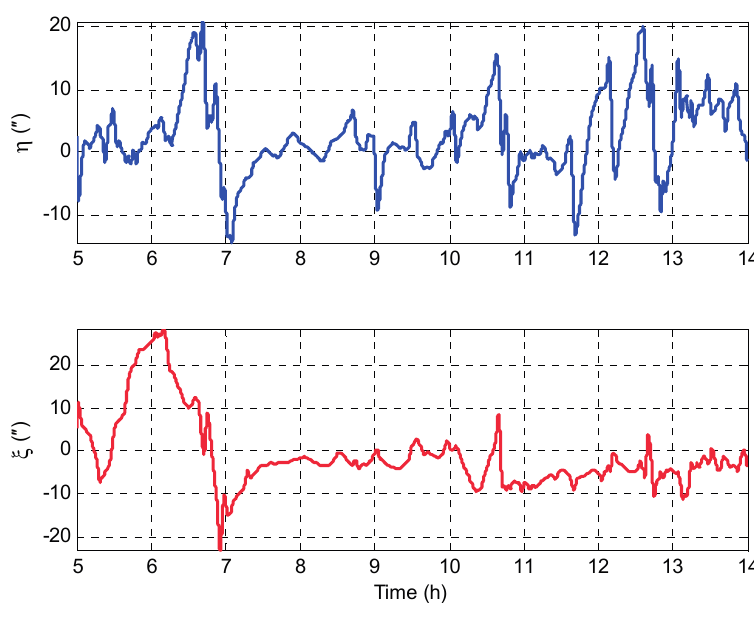
Figure 3. Gravity disturbance distribution